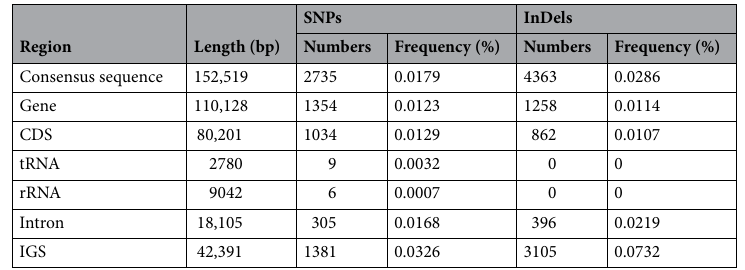
Table 3. Variation of the chloroplast genomes in Amaranthus.